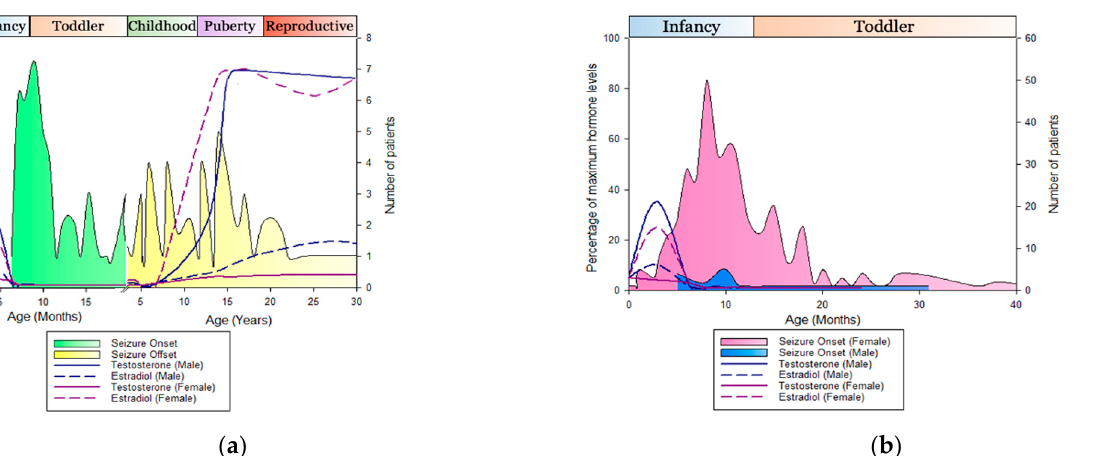
Figure 2. CE seizure onset and offset coincides with fluctuations in sex hormone levels: ( a ) a total of 54 CE females with recorded age of seizure onset and offset (Table S1) were plotted against average oestradiol and testosterone levels in males and females [29]. CE seizure onset coincided with a decrease in sex hormone levels after minipuberty, while seizure offset coincided with an increase in sex hormone levels during puberty. Figure updated from [25]; ( b ) age of seizure onset for a total of 395 CE females and 22 mosaic males (Table S2) was plotted against average oestradiol and testosterone levels in males and females during early development. Seizure onset for both CE males and females coincided with a decrease in sex hormone levels.